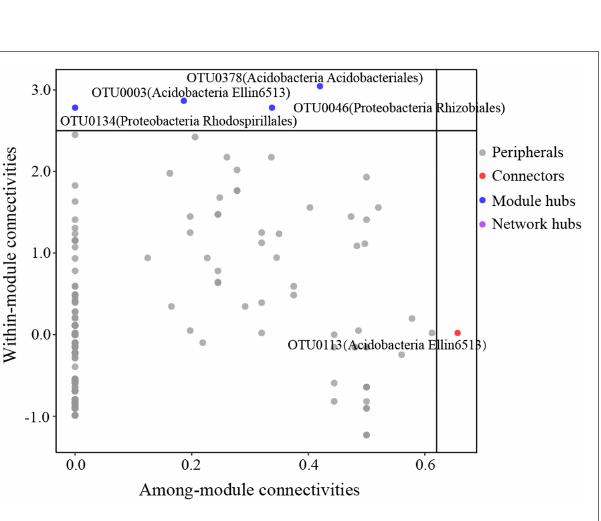
FIGURE 7 | Z-P plot showing the classification of nodes to identify putative keystone species in the C. oleifera plantations. Each symbol represents an OTU. One connector was identified, assigned to Acidobacteria. There were four module hubs in the network, two belonging to Acidobacteria and two belonging to